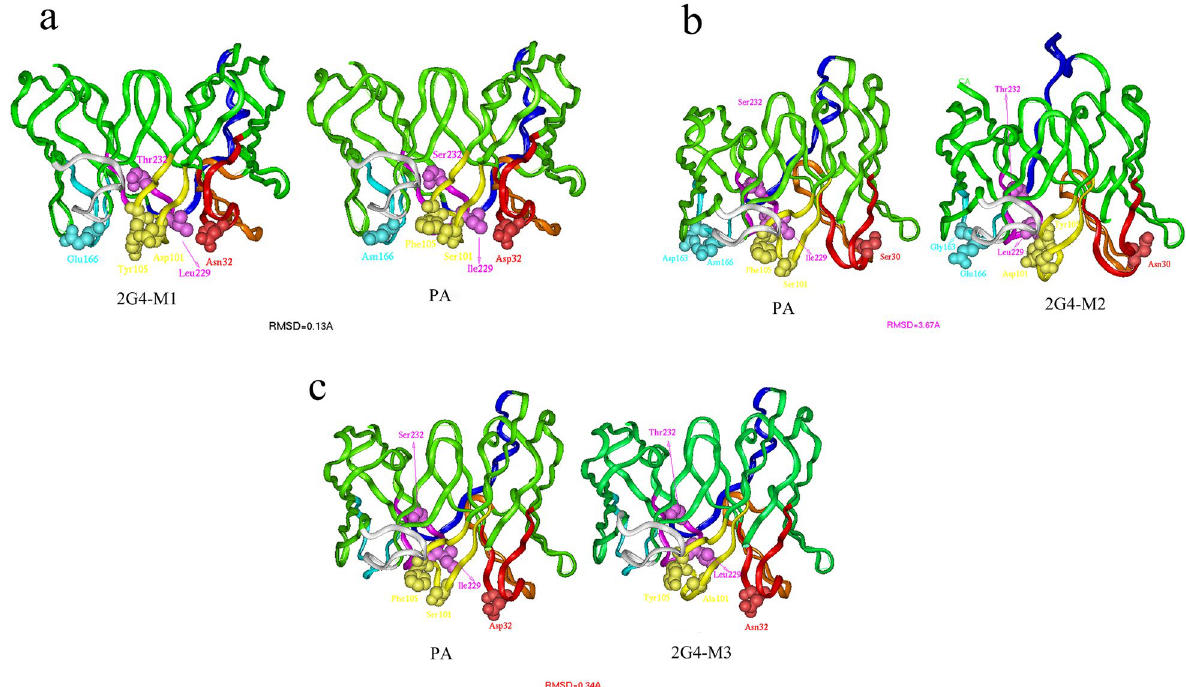
Figure 4. Conformation comparison of the 2G4 scFv fragment and the three mutants. The orientation of the parent (2G4 scFv) and mutants after structural superposition and translation. ( a ) The 3-D theoretical ribbon structures of 2G4-M1 and 2G4. ( b ) The 3-D theoretical ribbon structures of 2G4-M2 and 2G4. ( c ) The 3-D theoretical ribbon structures of 2G4-M3 and 2G4.